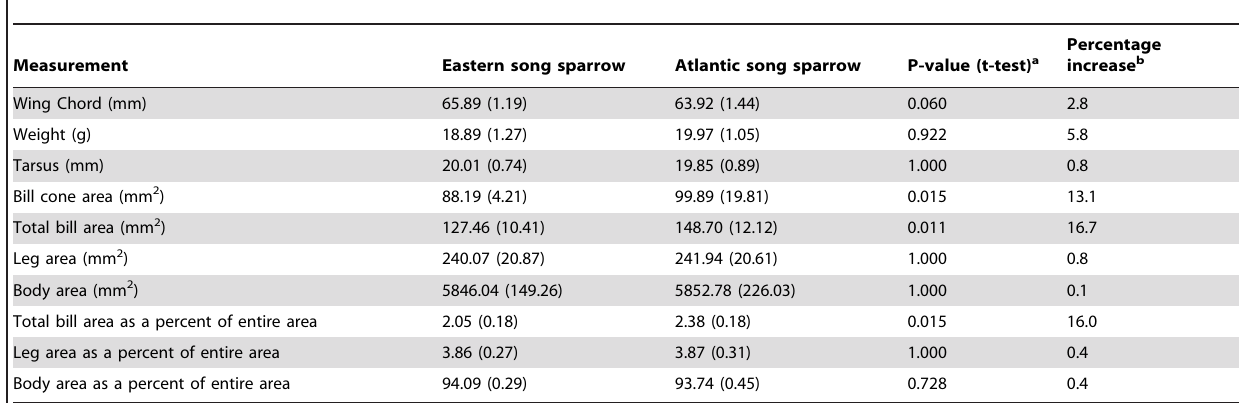
Table 1. Mean (and standard deviation) of morphometrics, with P-values based on t-tests (independent samples) for sparrows used in thermal imaging